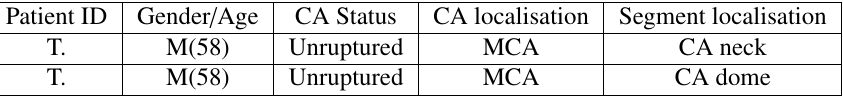
Table 1: Data on specimens. MCA-middle cerebral